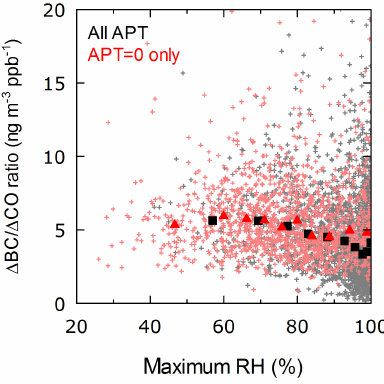
Figure 9. Observed (cid:49) BC /(cid:49) CO ratios as function of maximum RH (%) that air mass experienced in 72h before arrival at Fukue Island. All data (irrespective of APT) are shown by gray plus signs, while data with zero APT are shown by red plus signs. Black filled squares and red filled triangles show 10 bins sorted by maximum